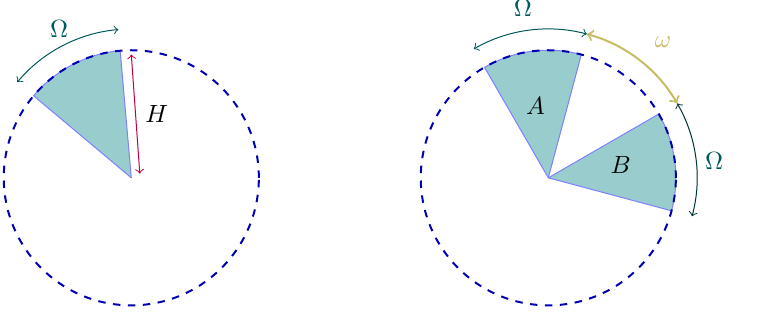
Figure 8 . EWCS as a function of hT 1 z for di(cid:11)erent values of (cid:18) and z . Left : E increases. Right : E W increases as z increases. Here we set H=G N = 1 and d = 2.